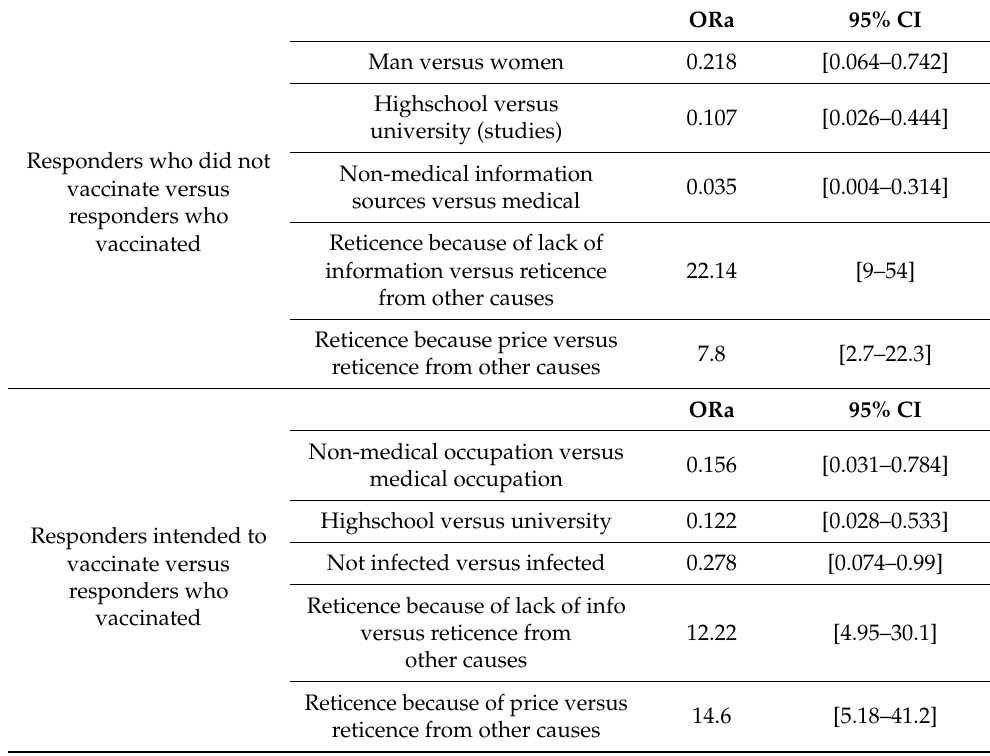
Table 3. Multinominal logistic regression in the category of people with